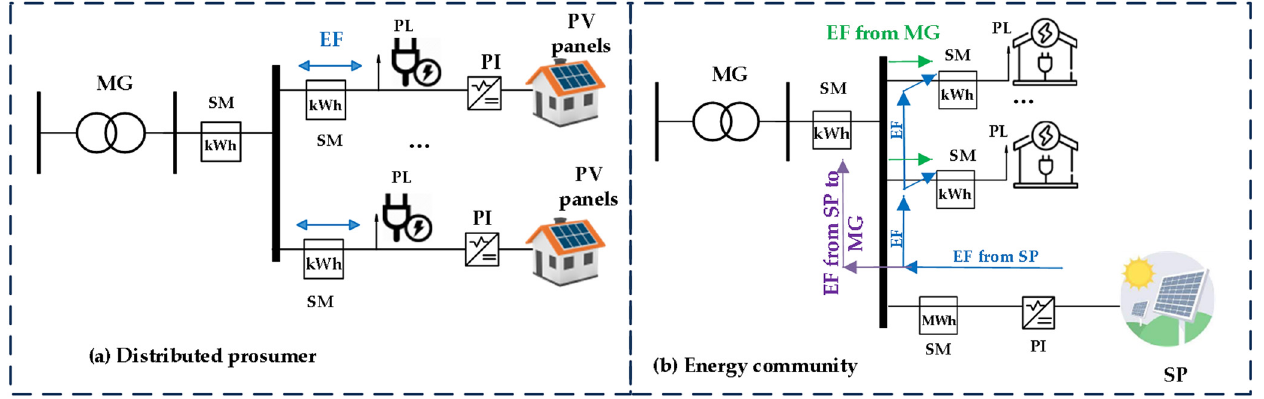
Figure 1. The layout of the network’s structure for both types of prosumers (MG—main grid; EF—energy flow; PL—power load; PI—power inverter; SM—smart meter; SP—solar plant).